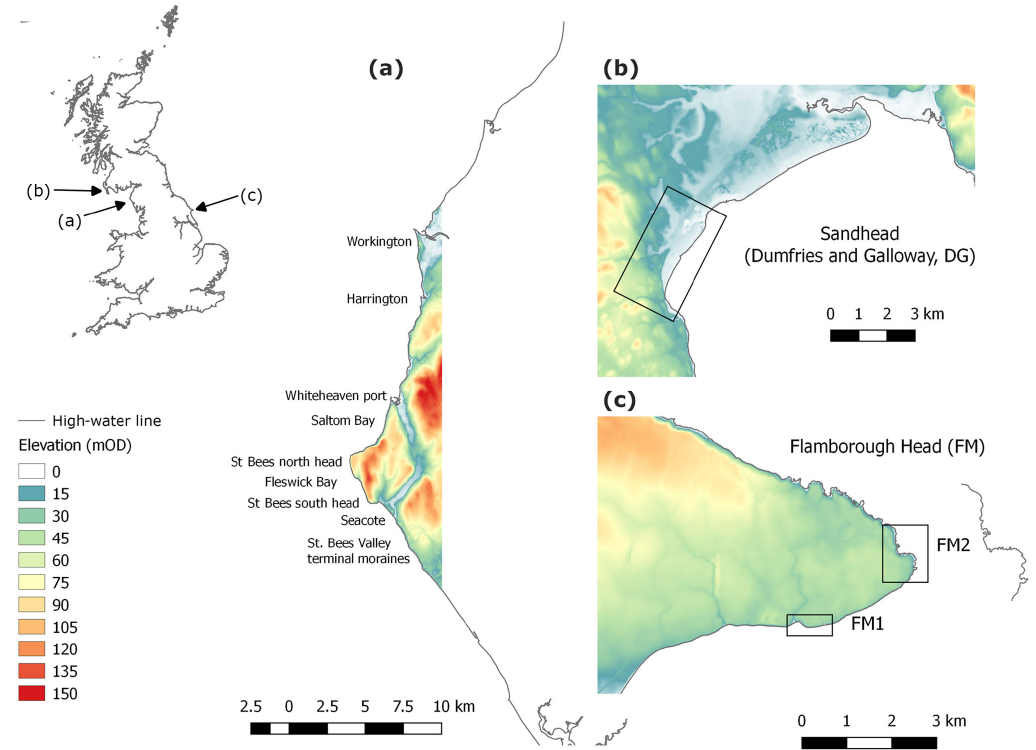
Figure 2. The NEXTMap DEM (mOD: metres ordinance datum) of selected study sites around Britain’s coastline; (a) St Bees head in northwest England, used for the model sensitivity analysis. The name of the main locations cited in the text are shown along this coastal stretch, (b) Sand Head and (c) Flamborough head sites are non-active and active cliffed coastlines sites used for the manually digitized uncertainty analysis. At Flamborough, two study sites were selected with cliffs of similar heights but with relative uniform coastline (FH1) and very irregular coastline shapes